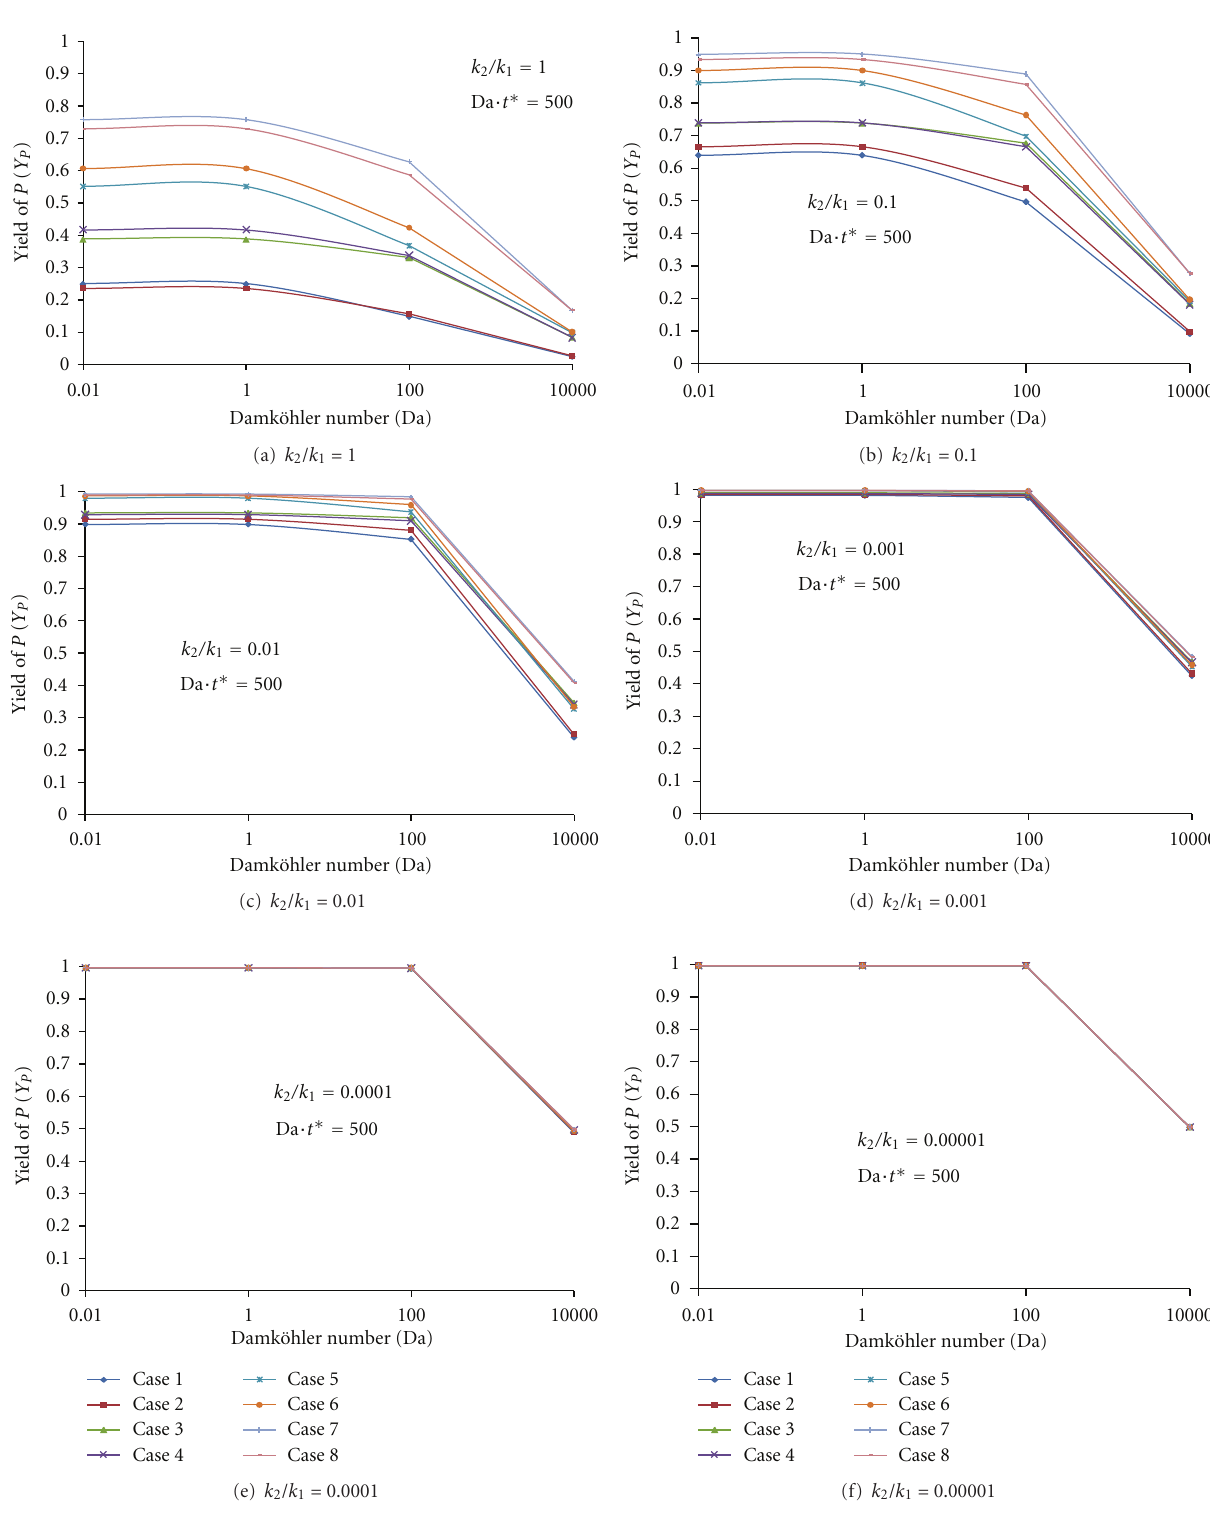
Figure 2: Plots of yield of P versus Da for decreasing k 2 / k 1 ratios for the C-C